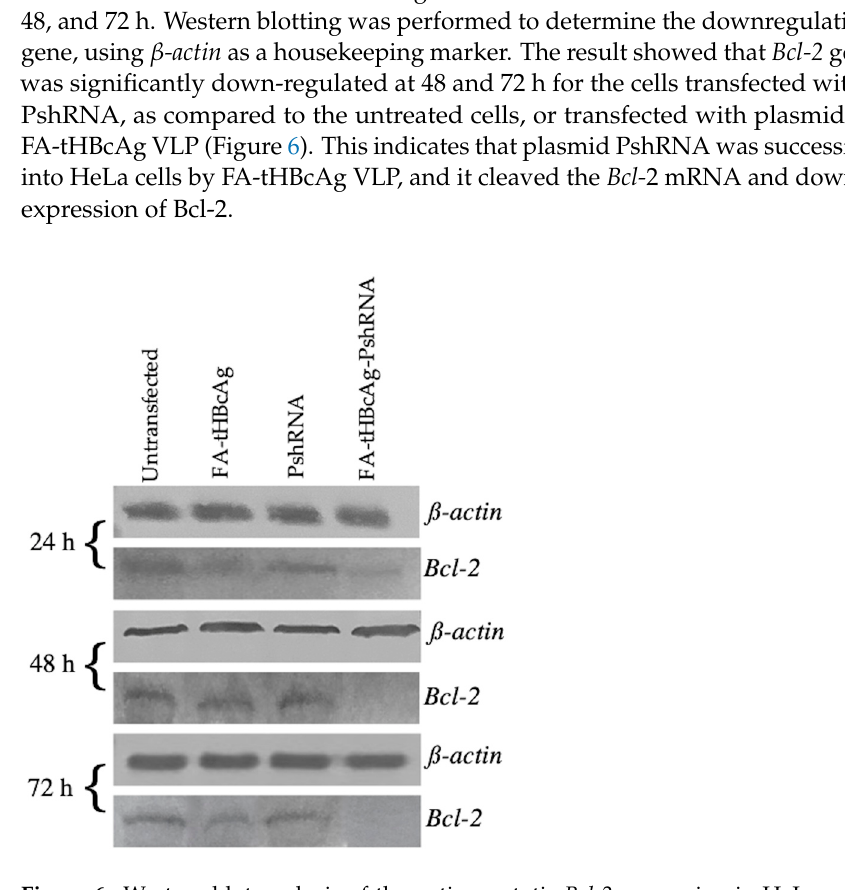
Figure 6. Western blot analysis of the anti-apoptotic Bcl-2 expression in HeLa cells treated with tHBcAg VLP encapsidating PshRNA and conjugated with FA. HeLa cells with 70% confluency was treated with FA-tHBcAg (truncated hepatitis B core antigen conjugated with folic acid), PshRNA (plasmid synthesizing short hairpin RNA), and FA-tHBcAg-PshRNA (PshRNA packaged with truncated hepatitis B core antigen and conjugated with folic acid). Untreated cells served as a control. The cells were harvested and analyzed with western bloting after 24, 48 and 72 h post-transfection. β ‐ actin served as a control. A significant reduction of Bcl ‐ 2 expression was observed at 48 and 72 h post ‐ transfection with FA ‐ tHBcAg ‐ PshRNA VLP.